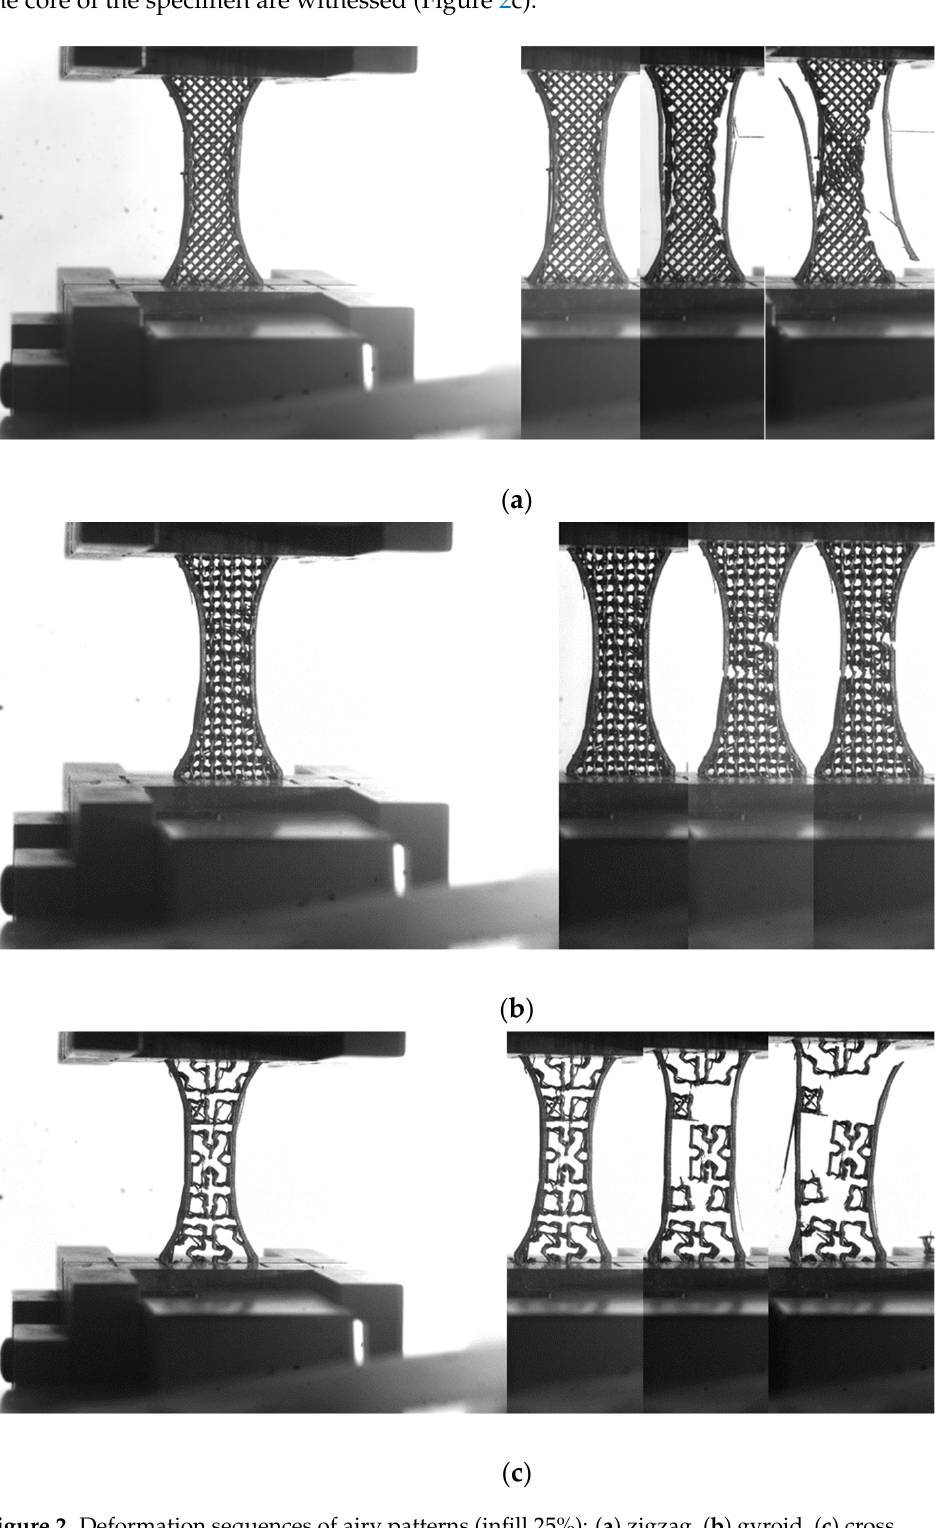
Figure 2. Deformation sequences of airy patterns (infill 25%): ( a ) zigzag, ( b ) gyroid, ( c ) cross.